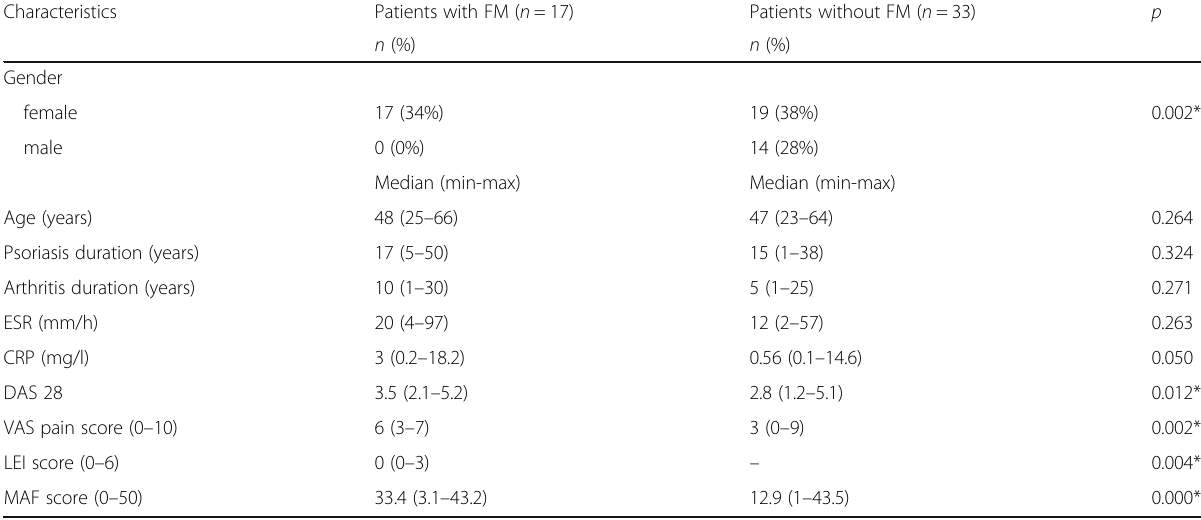
Table 2 Comparison of the clinical parameters in the psoriatic arthritic patients ( n = 50) with and without fibromyalgia